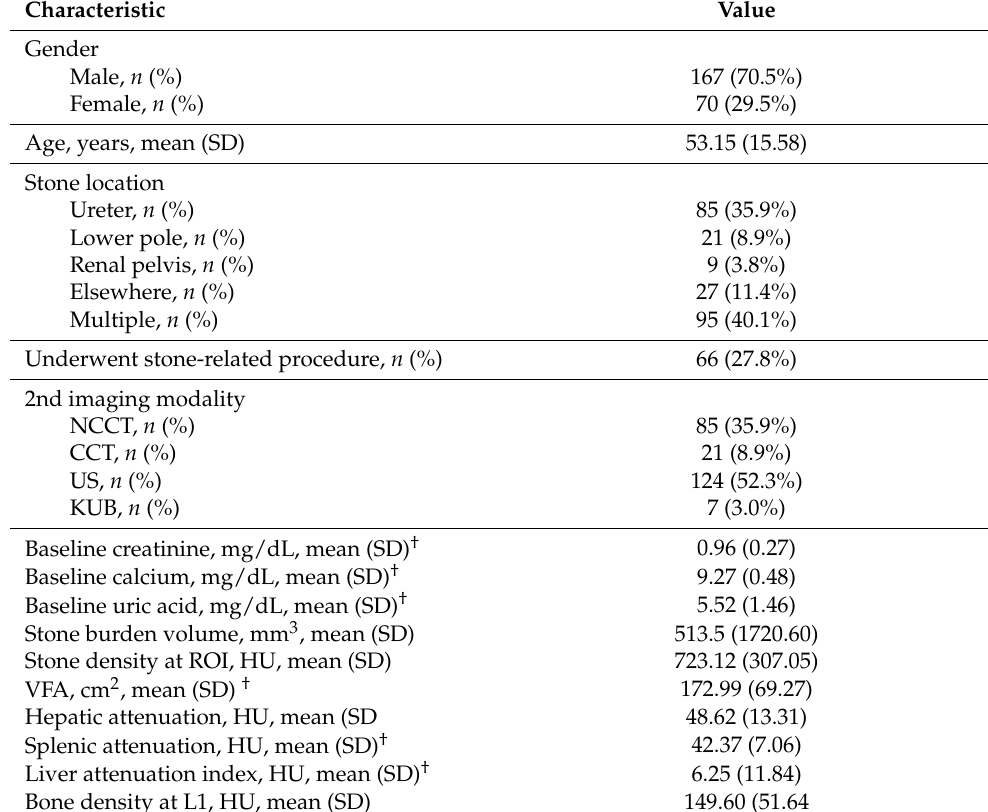
Table 1. Baseline demographic, clinical and imaging characteristics of patients ( n = number; SD = standard deviation; HU = Hounsfield units; VFA = visceral fat area).